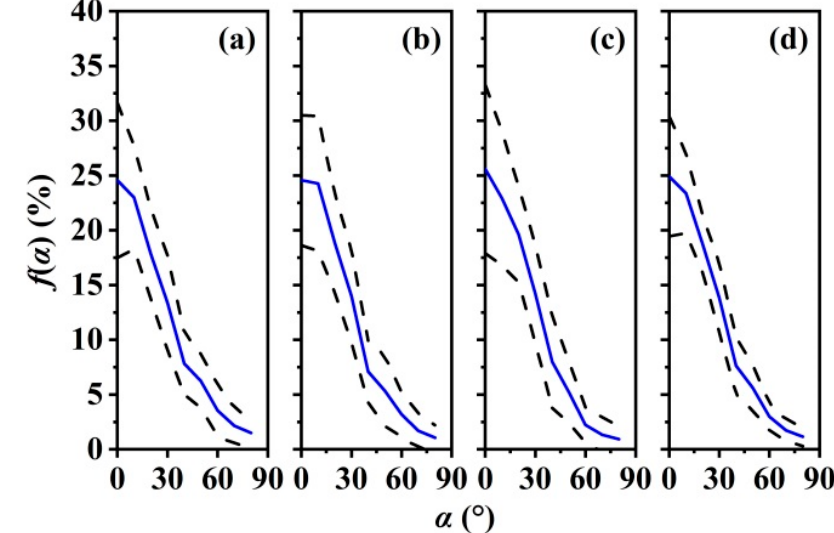
Figure 6. Leaf angle distribution f( α ) of Moso bamboo crowns with a 10° leaf angle interval. The blue solid lines are the mean percentages of f( α ) for the 29 crowns, and the dashed black lines are the standard errors of the mean percentages of f( α ) . ( a ) Top; ( b ) middle; ( c ) bottom; and ( d ) total crown. G( θ ) of MB crowns was simulated based on f ( α ) according to Equation (12) (Figure 7). Compared plagiophile, spherical, and uniform cases [63], G( θ ) of MB crowns tends to be planophile.